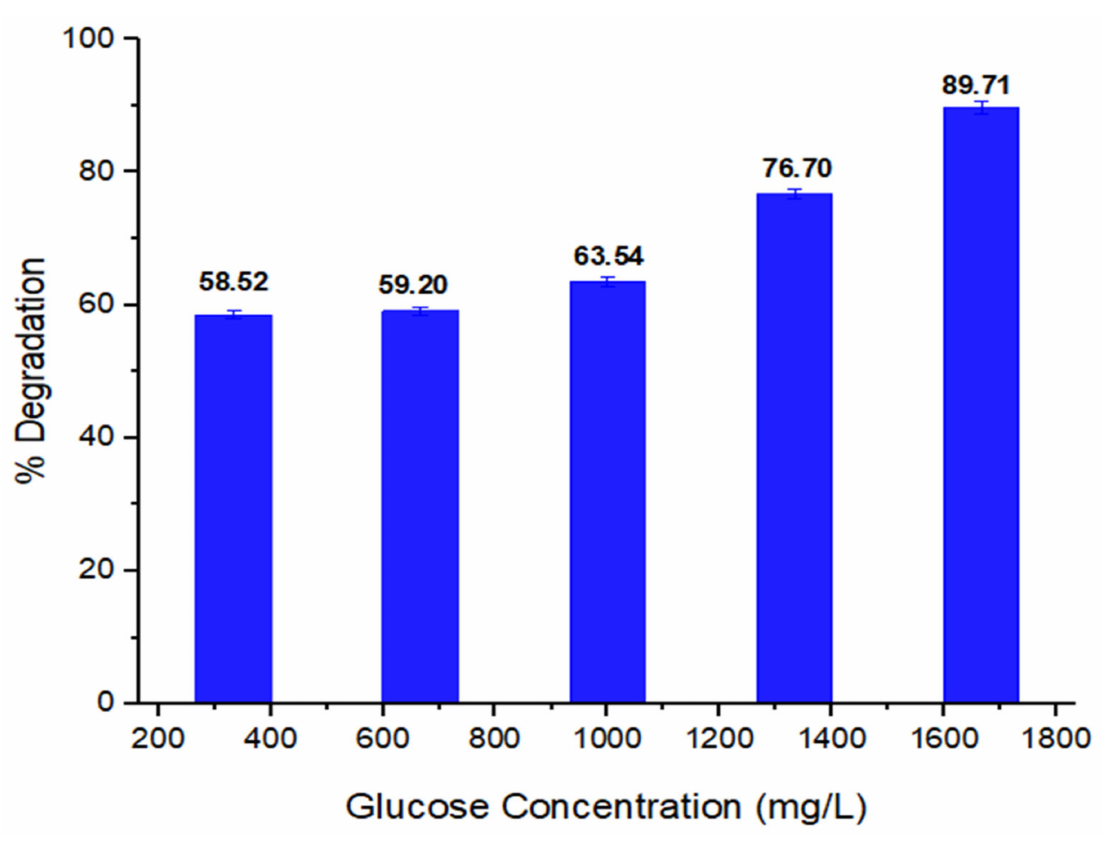
Figure 7. Effect of Glucose Concentration on Basic Orange 2 Dye % degradation.